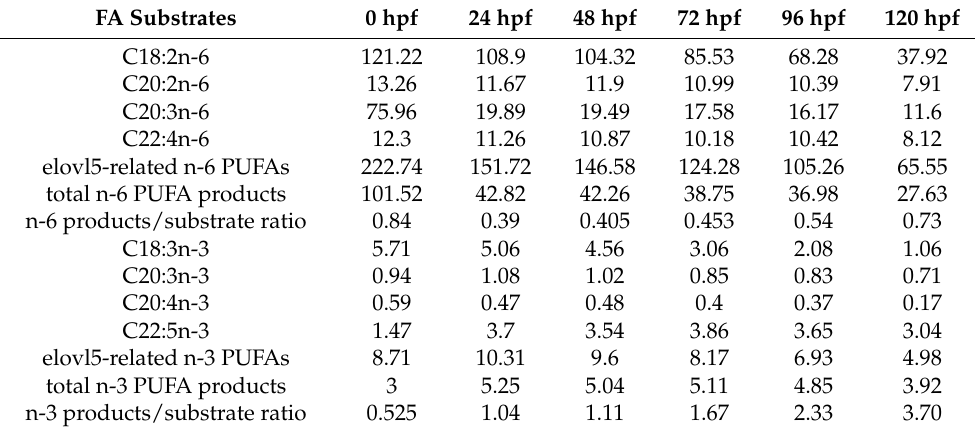
Table 2. The contents of elovl5-related PUFAs during common carp embryo development. FA